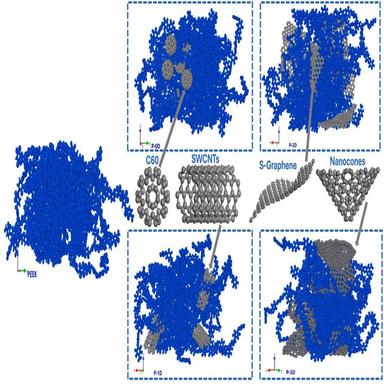
Illustration of all the modeled systems with a visual representation of the nanostructures integrated into the PEEK matrix.